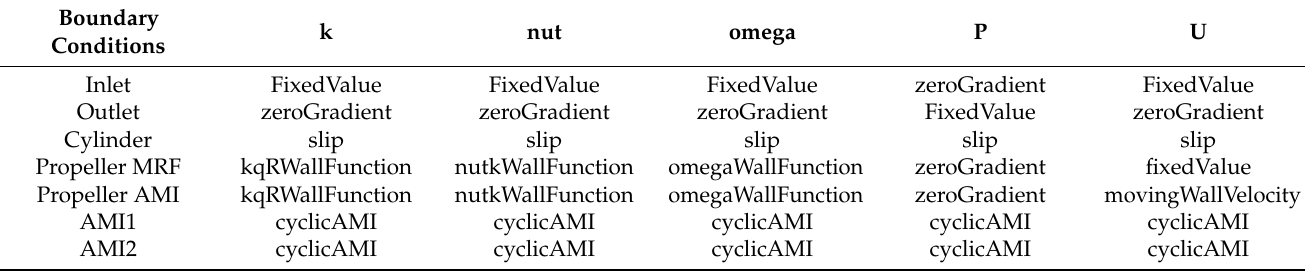
Table 1. Boundary conditions for wind turbine